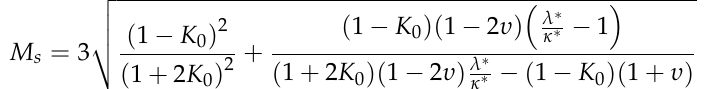
Figure 3b,c show the yield surface and stress–strain relation of the Soft Soil model.